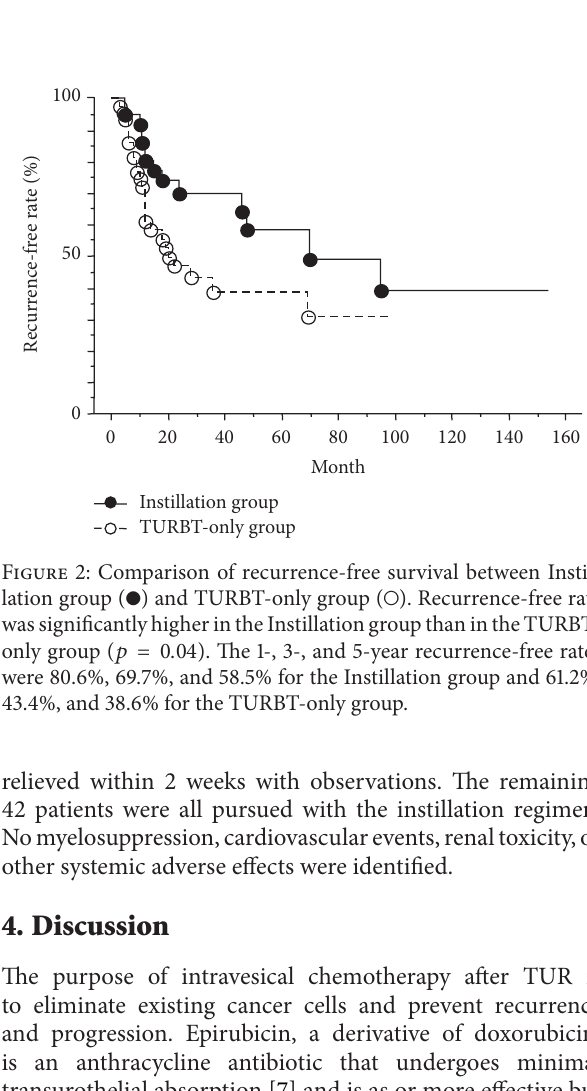
42 patients were all pursued with the instillation